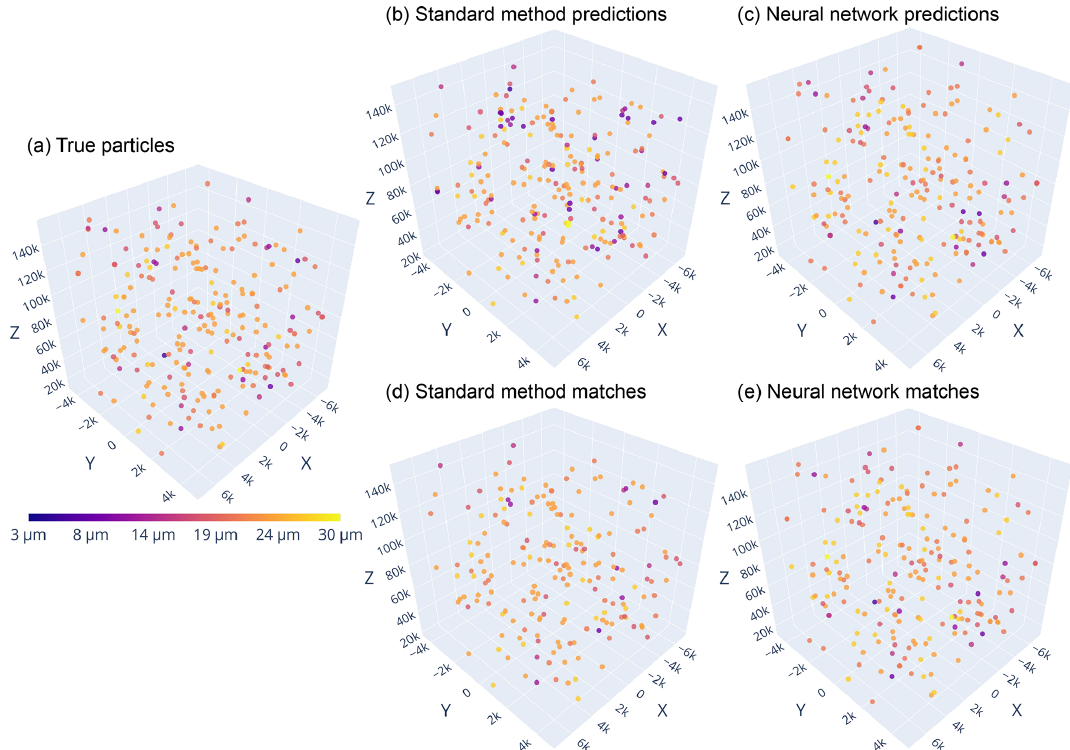
Figure 12. The particles in hologram 10 from the HOLODEC test set are plotted in 3D for (a) the true particles as determined by manual evaluation, (b, d) the standard method predictions, and (c, e) the neural network predictions. In (b) and (c) , all predictions are shown for either approach. In (d) and (e) , only pairs between true particles and those predicted by the standard method or the neural network, respectively, are shown. The color bar shows the diameter of the particles and applies to all panels. Note that the three axes do not have the same size, and therefore distances between particles do not